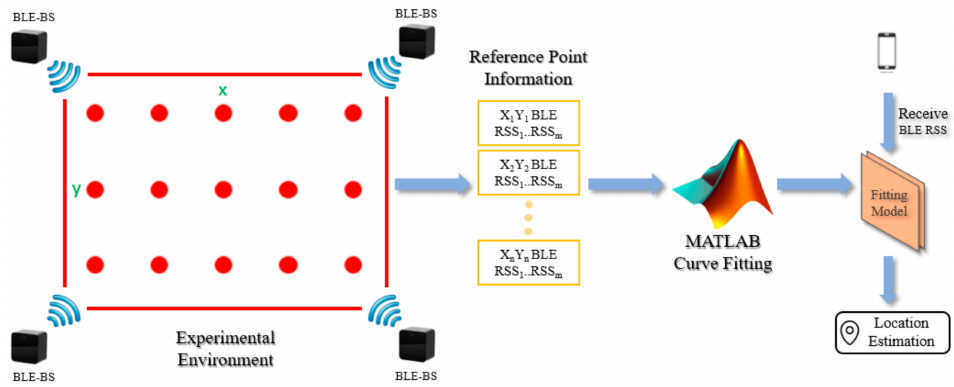
Figure 4. Schematic Diagram of System